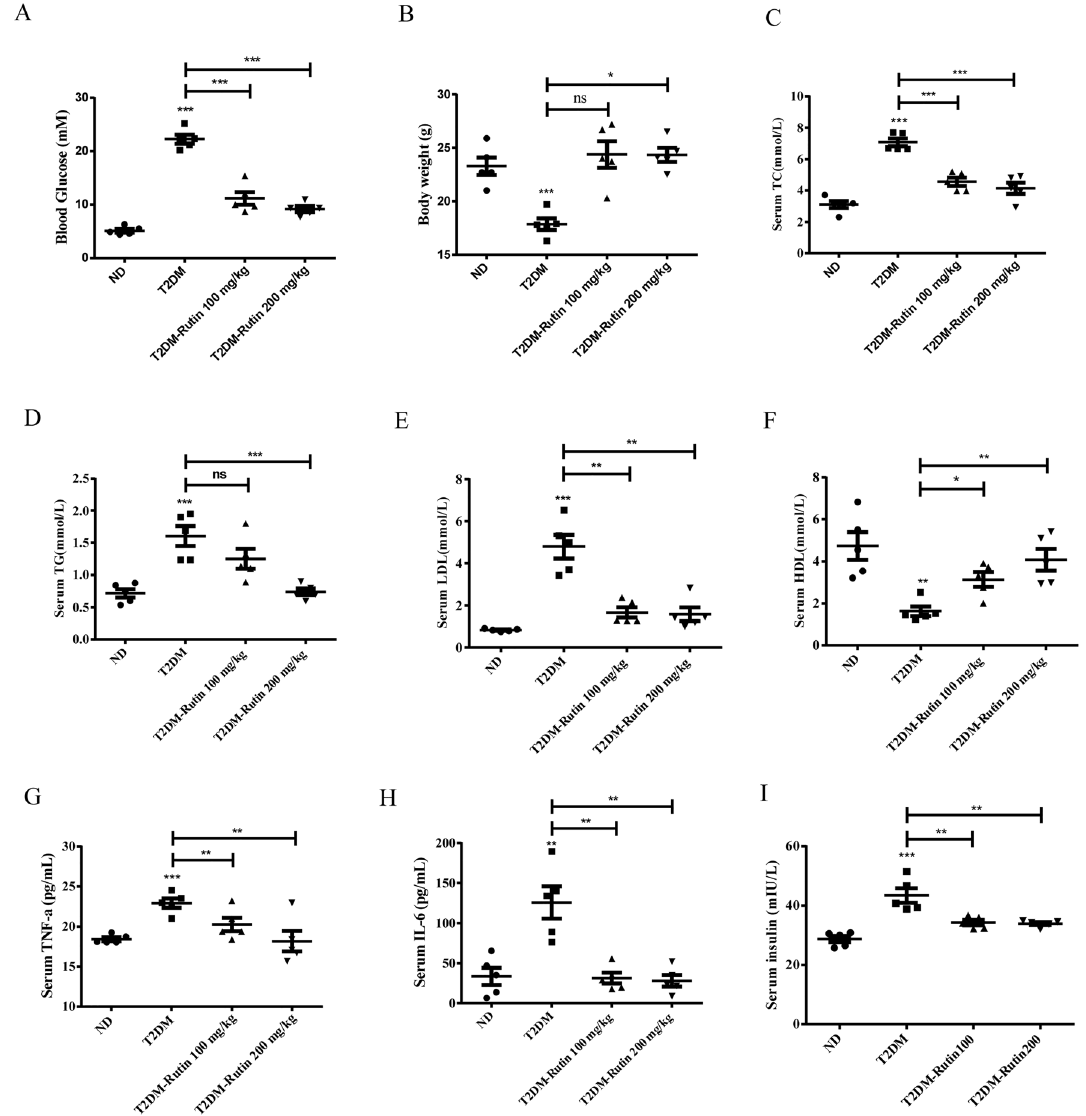
Figure 2. Effects of rutin on serum glucose and lipids in HFD/STZ-induced diabetic mice. ( A ) Fasting serum glucose. ( B–I ) Serum TC, TG, LDL-C, HDL-C, TNF-α, IL-6, and insulin levels. Values are means ± SD (n = 5): *p < 0.05, **p < 0.01, ***p <